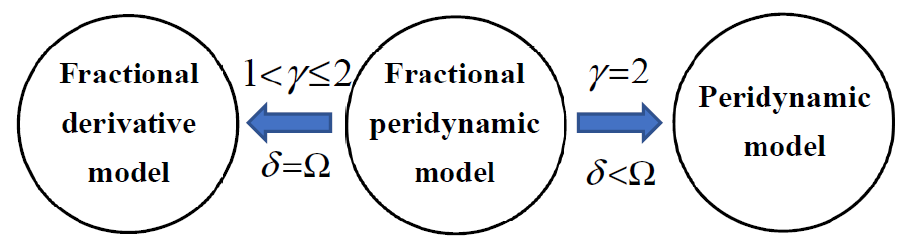
Figure 5. The relationship among three models (PD model, FPD model, and FDM).